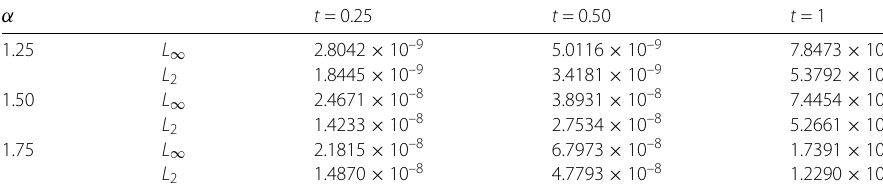
Table 5 Error norms for Problem 2, when N = 80 and (cid:2) t = 0.001 α t = 0.25 t = 0.50